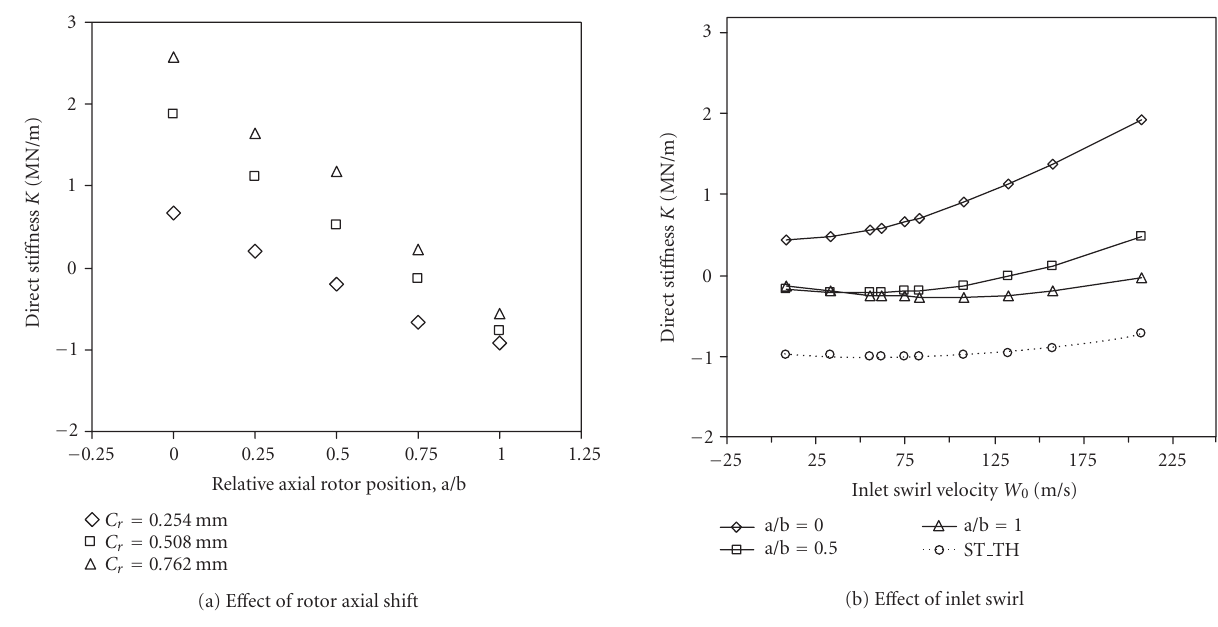
Figure 10: Predicted direct sti ff ness K : (a) e ff ect of rotor axial shift; (b) e ff ect of inlet swirl velocity.